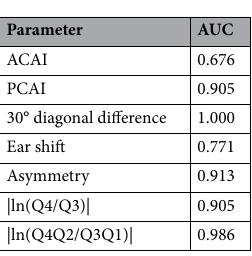
Table 4. ‘Severe PP’ compared with ‘no + moderate PP’.